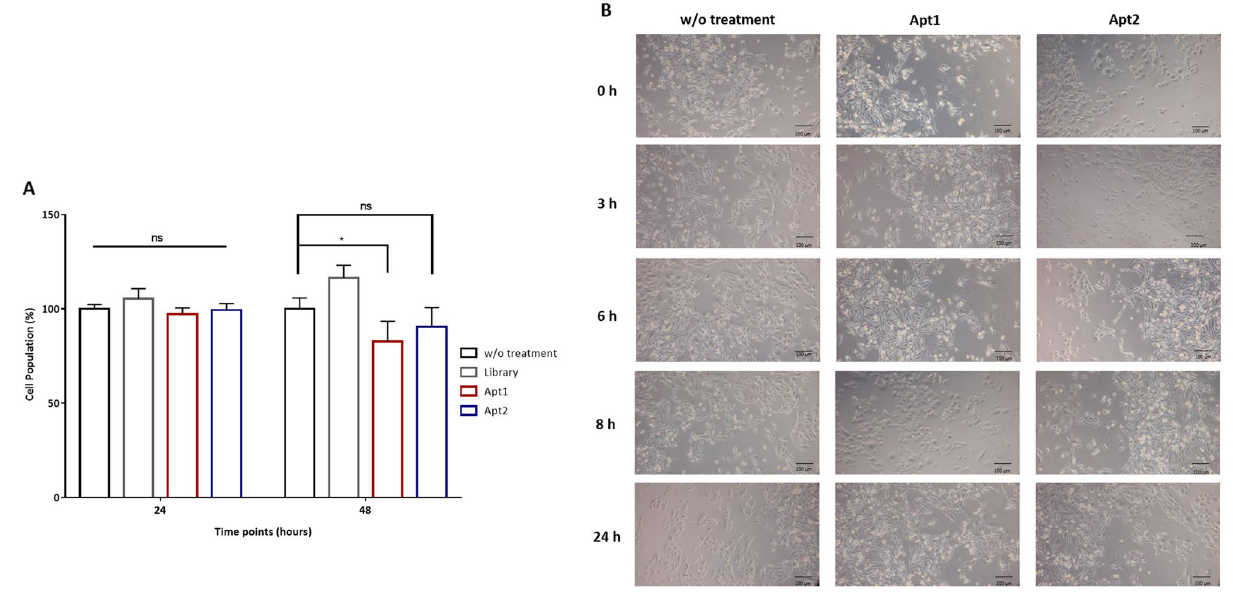
Figure 7. In vitro toxicity of Apt1 and Apt2. ( A ) Cell viability was evaluated by MTT assay. MDA-MB-231 cells were incubated with Apt1 and Apt2, respectively, for 24 and 48 h. The ssDNA library was used as a negative control. All data are expressed as the mean ± SD of three independent experiments. Two-way ANOVA indicates statistically significant differences within the group assessed by Sidak’s post-test and denoted as follows: *ρ ≤ 0.1 and ns ρ > 0.05. ( B ) Microscopy images of MDA-MB-231 cells treated with Apt1 or Apt2 for 0 h, 3 h, 6 h, 8 h, and 24 h. Non-treated cells were used as negative